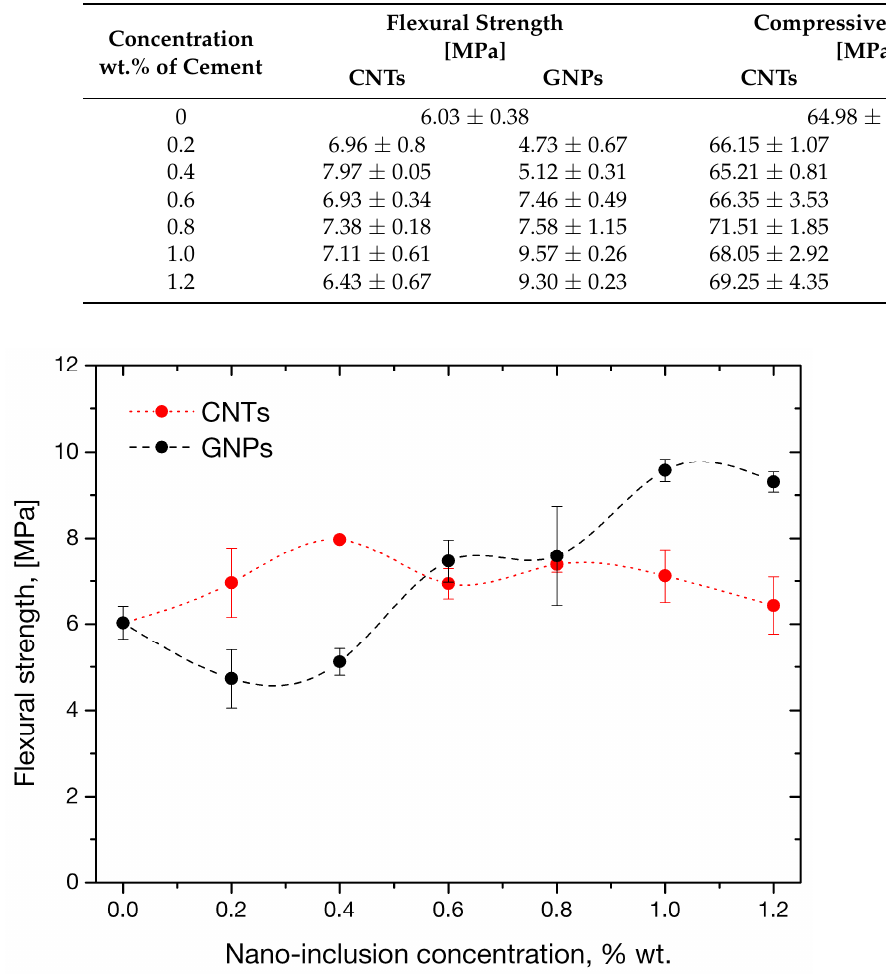
Figure 6. Flexural strength variation in mortars as function of CNT and GNP concentration.